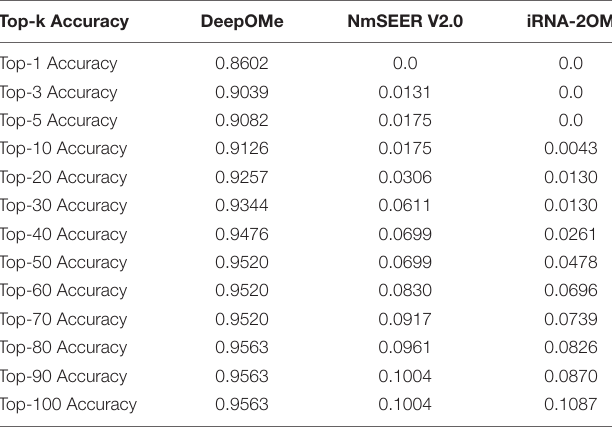
TABLE 1 | Comparison of Top-k Accuracy between DeepOMe, NmSEER V2.0, and iRNA-2OM in testing set.